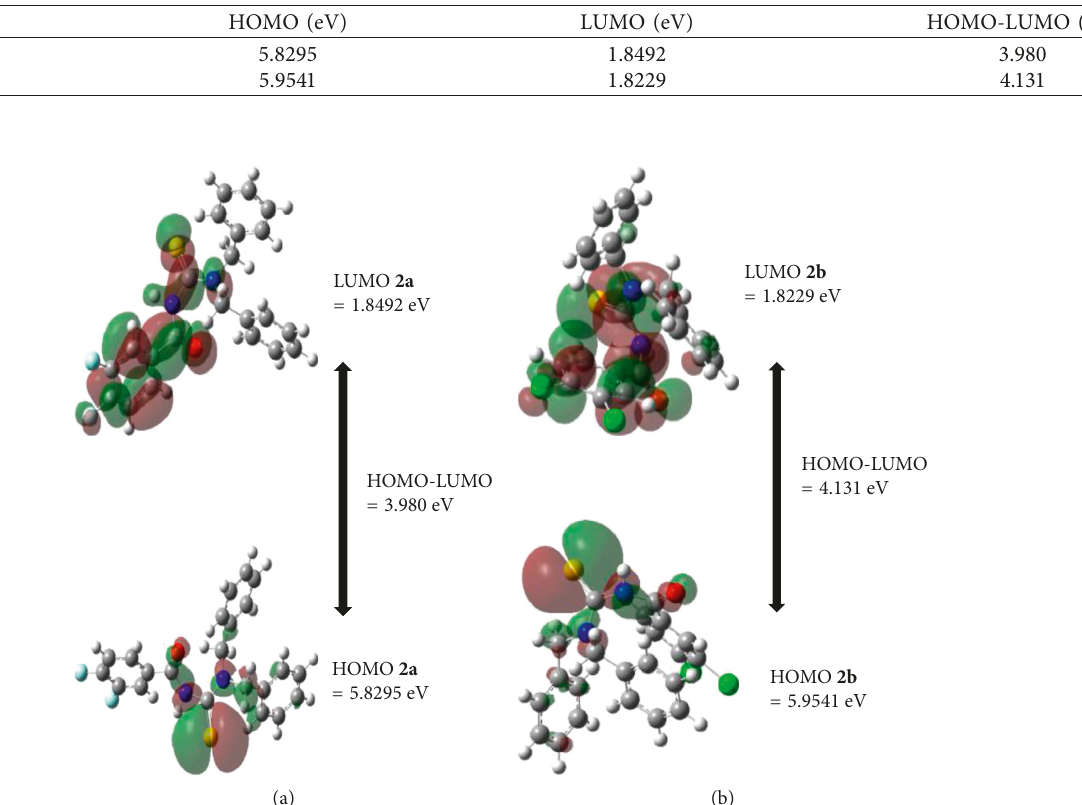
Table 3: List of HOMO-LUMO energy of compounds 2a and 2b .